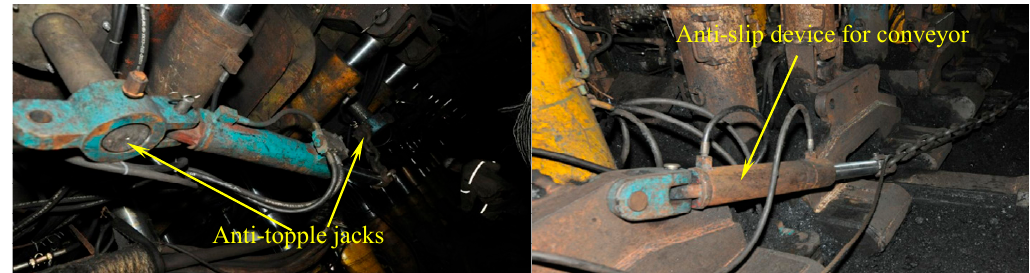
Figure 5. Supplementary field measures employed to increase stability in Tangshan coal mine.